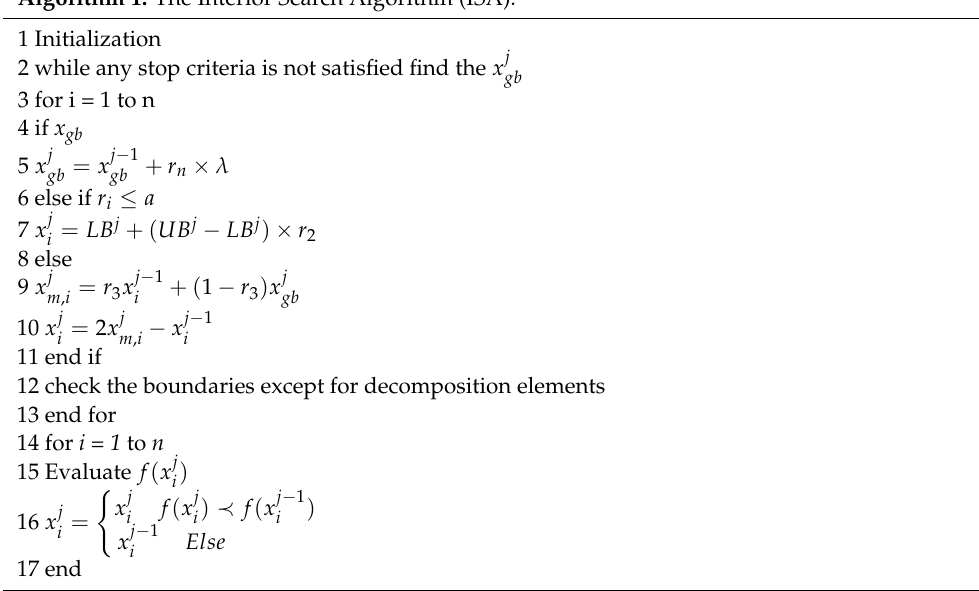
Algorithm 1: The Interior Search Algorithm